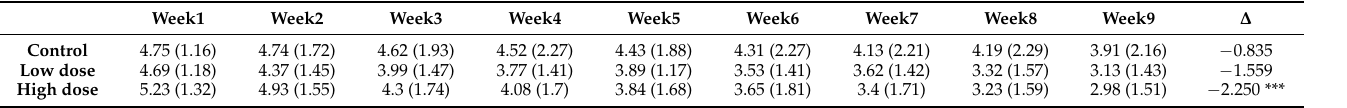
Table 3. Weekly mean (standard deviation) of visual analogue scale (VAS) for perceived pain during the period of study. ∆ represents the increment from the start to the end of this trial. Significance level for the differences between values at the beginning and end of this trial.